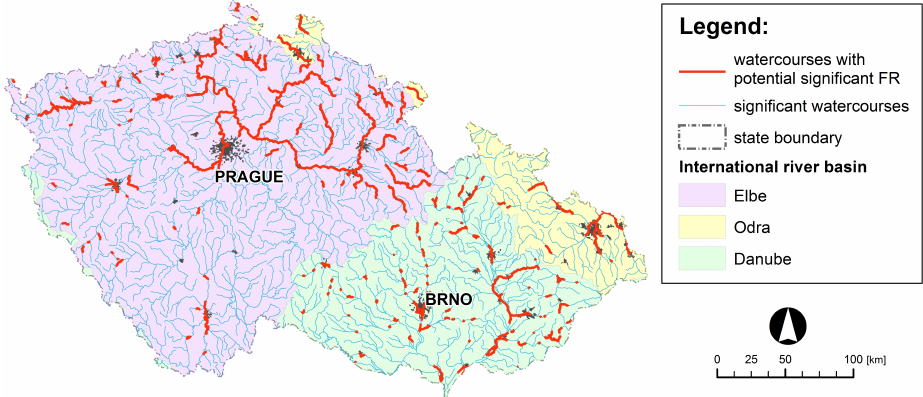
Fig. 1. Selected watercourses in the CR which have high flood risk (FR) potential and for which more detailed evaluation is proposed (Drbal and ˇ St ˇ ep´ankov´a, 2008).